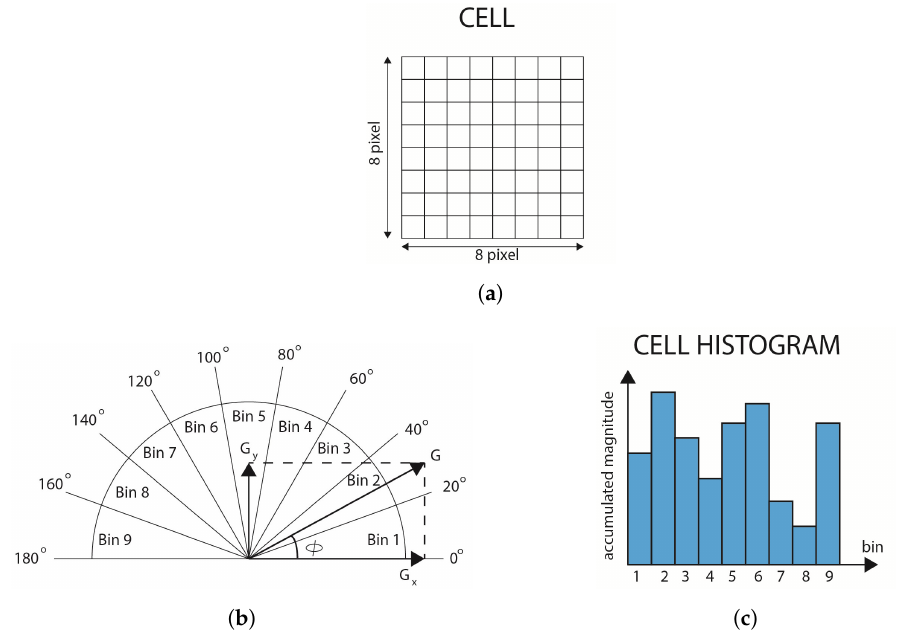
Figure 1. An illustration of how HOG features are generated. ( a ) Feature is calculated based on a cell of 8 x 8 pixel; ( b ) Each pixel has a magnitude gradient G , and orientation gradient φ ranged from 0 to 180°; ( c ) Each pixel contributes its magnitude gradient to the appropriate bin among 9 bins to generate the final HOG feature vector of a